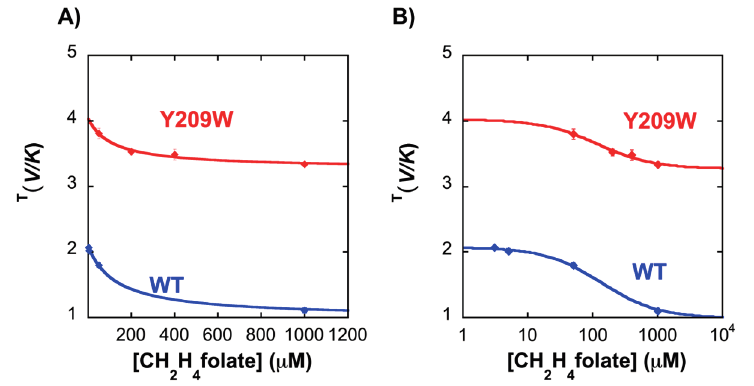
Figure 5. Observed H/T KIE for proton abstraction as a function of CH 2 H 4 folate concentration (( A ) on linear scale and ( B ) on logarithmic scale). Data with WT (Blue) and Y209W (Red) are compared. The lines are fitted to Equation